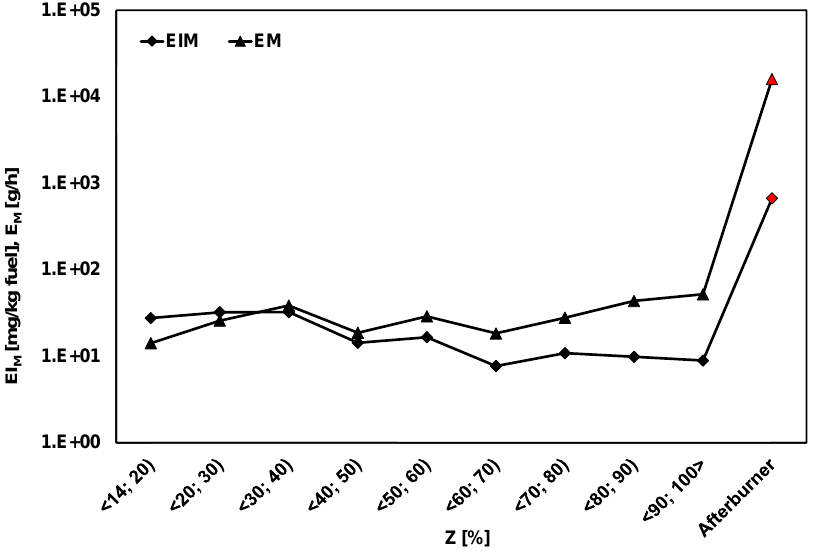
Figure 2. PM Mass Emission Index (EI M ) and PM Mass Emission Intensity (E M ) versus relative position of the power lever (Z).